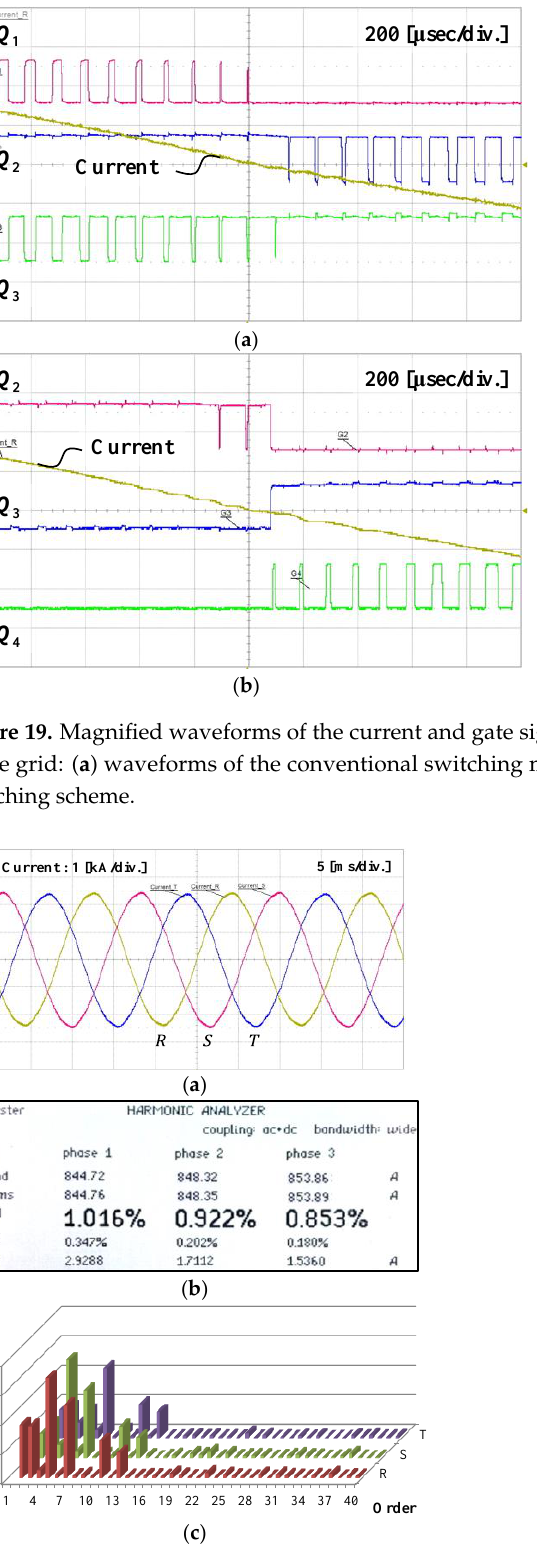
Figure 20. Experimental results of the conventional switching method: ( a ) current waveforms; ( b ) THD of the current; ( c ) harmonic analysis.